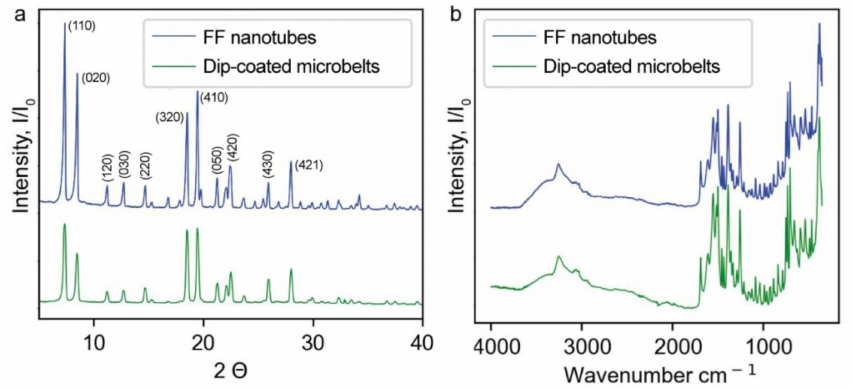
Figure 3. Crystal structure comparison of FF nanotubes and dip-coated microbelts: ( a ) XRD diffrac- tograms, ( b ) FTIR spectra.